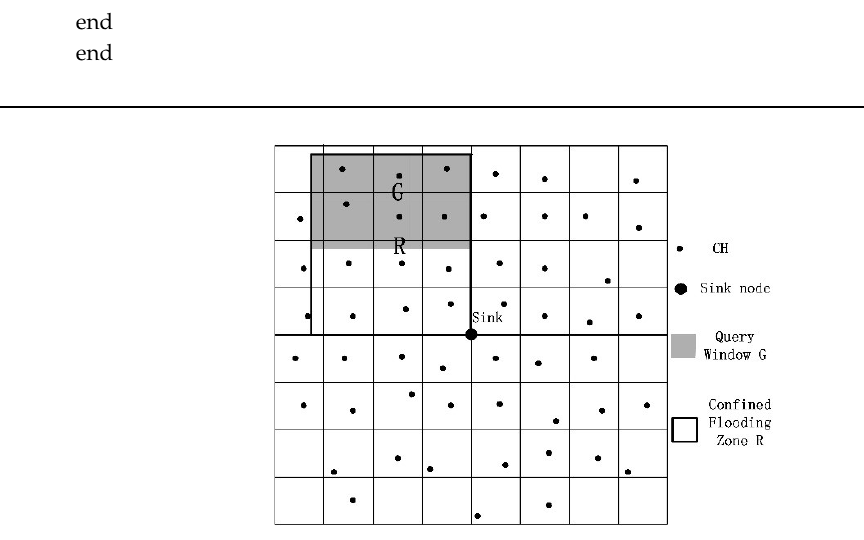
Figure 7. Sensor data transmission zone.